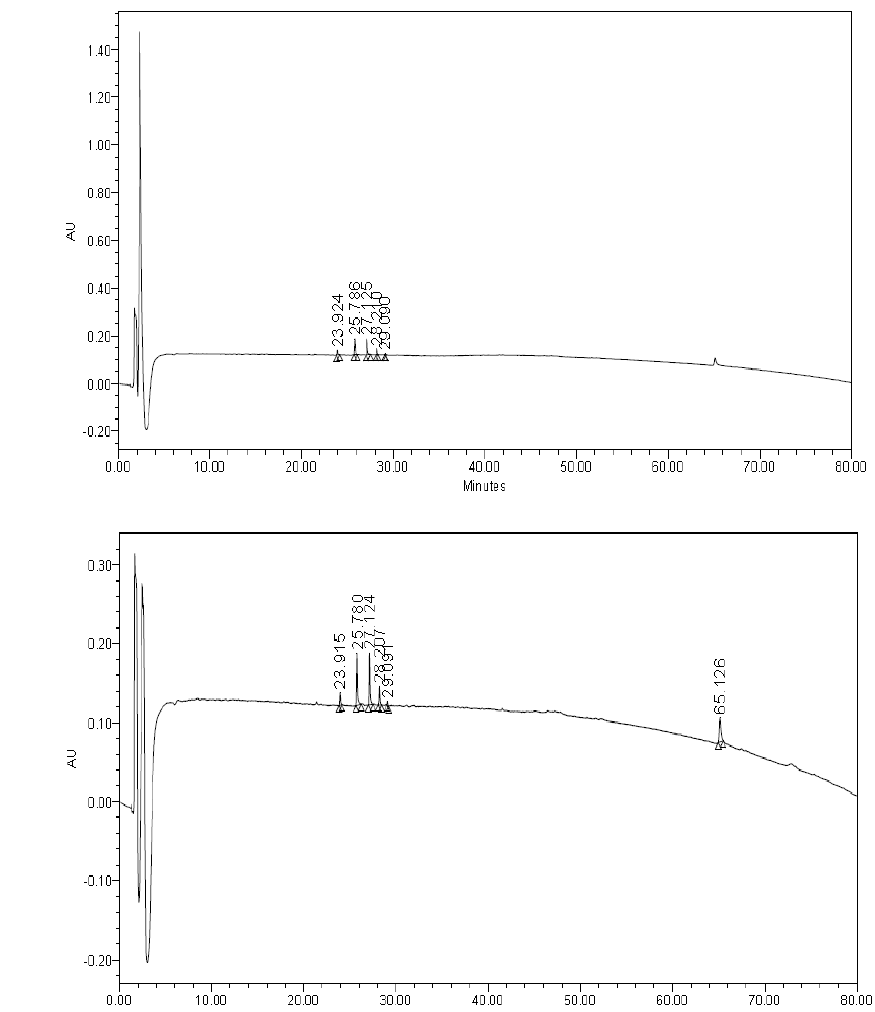
Figure 3. High performance liquid chromatography chromatograms of the biosurfactant produced by ( a ) Bacillus sp. HIP3 and ( b ) the standard Surfactin (Sigma-Aldrich, USA).